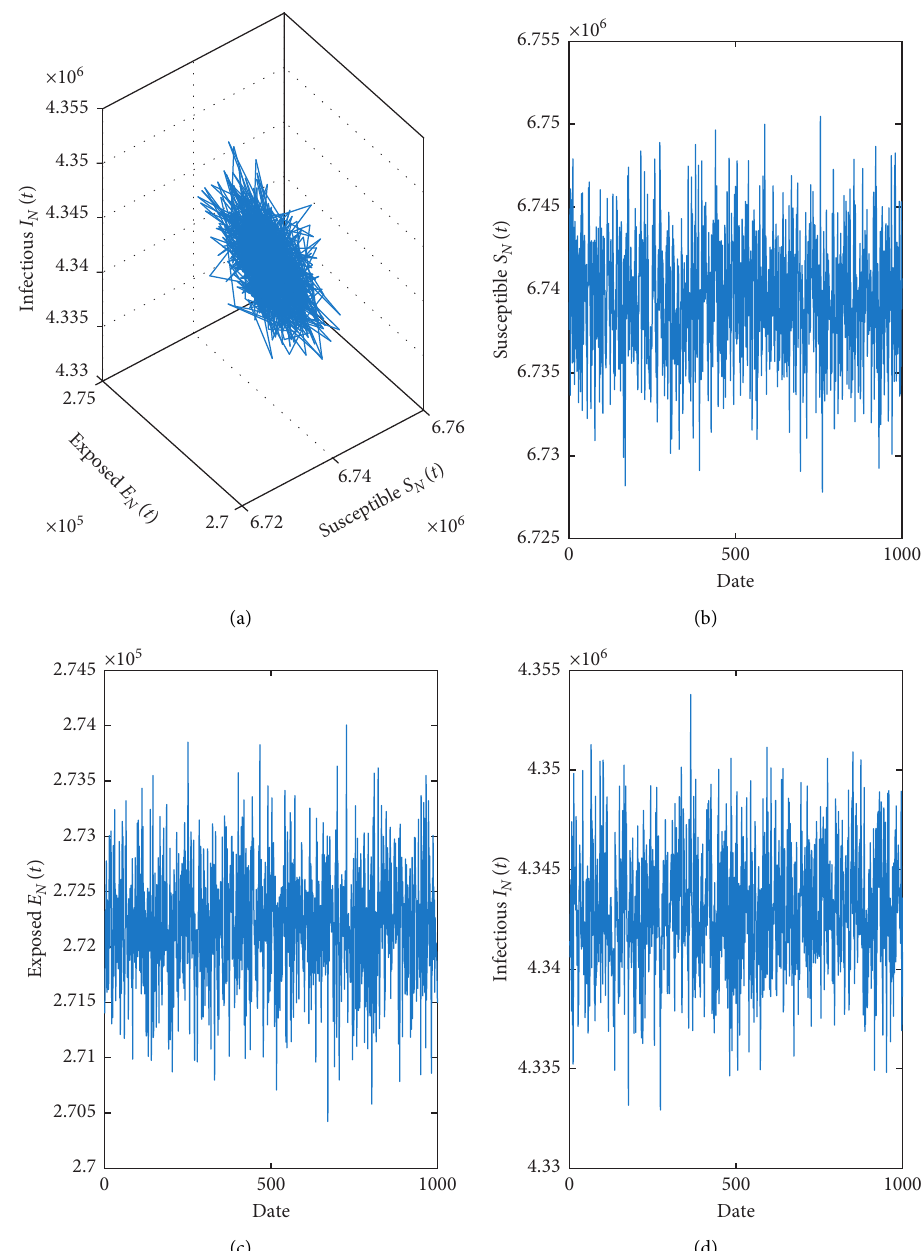
Figure 7: (a) Approximation of the quasi-stationary distribution; (b) marginal density of the susceptible; (c) marginal density of the exposed; (d) marginal density of infectious